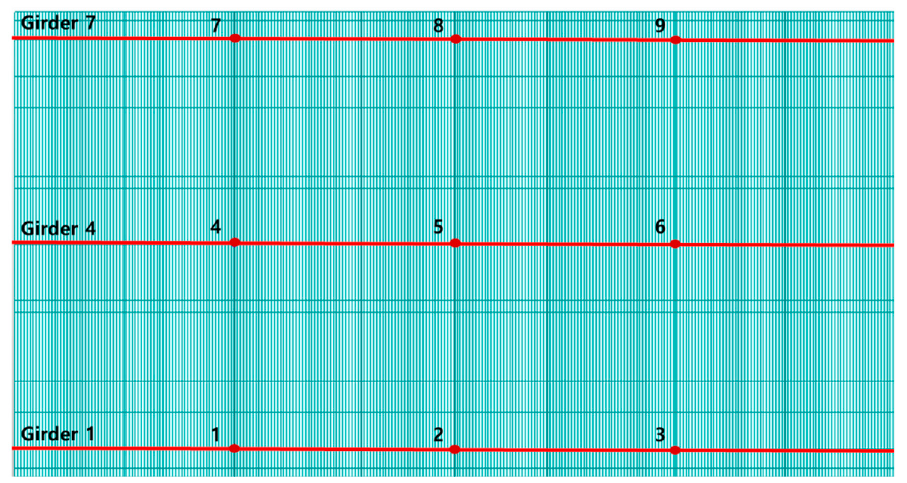
Figure 4. Acceleration measurement points on the bridge deck.